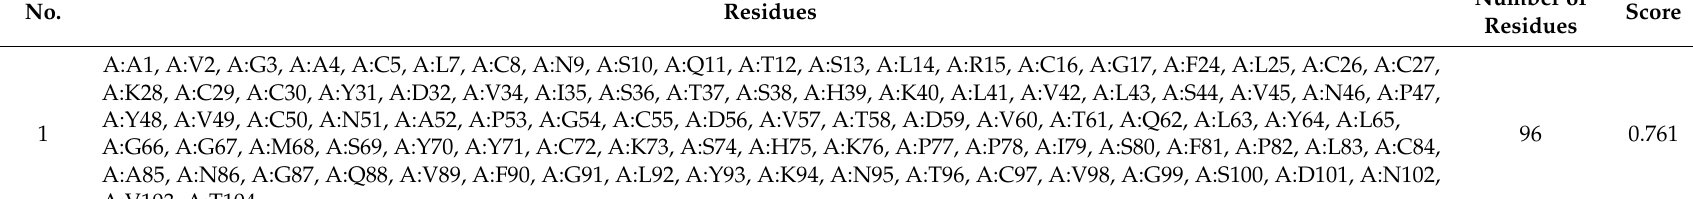
Table 12. Conformational epitopes from SARS-CoV-2 Nsp13 helicase.